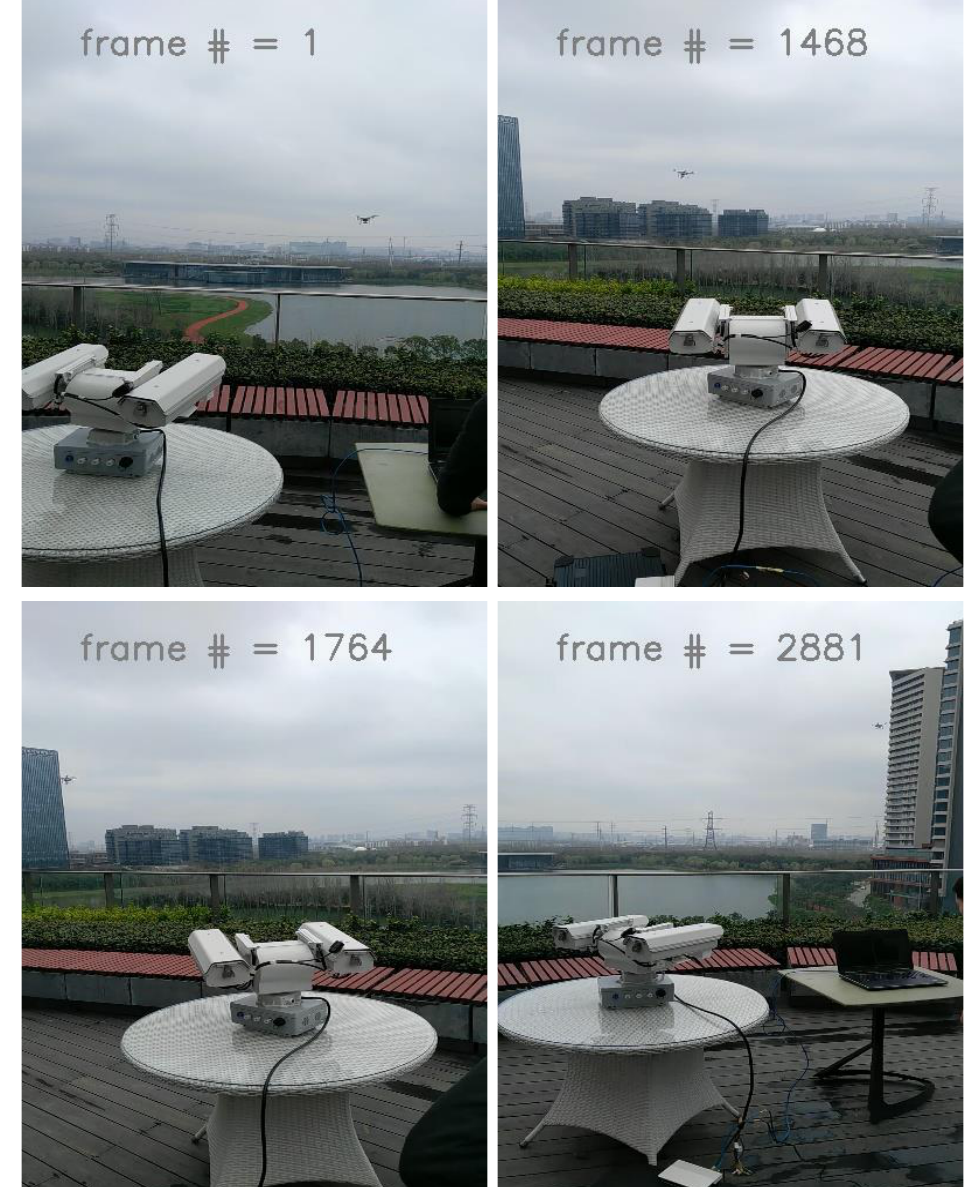
Figure 15. Illustration of the proposed method used for the detection and tracking of drones in